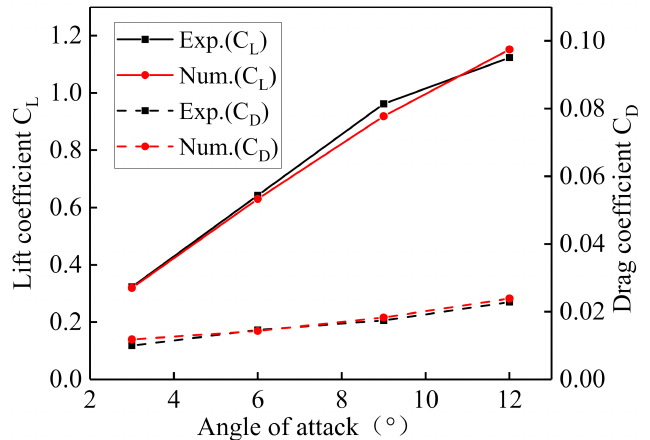
Figure 7. Comparison of the simulated lift and drag coefficients with the experimental data.